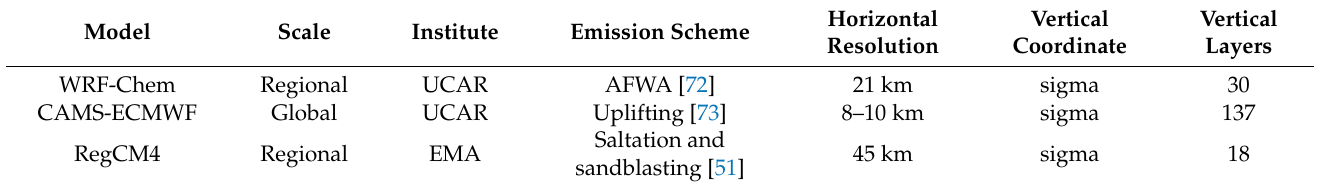
Table 2. Main characteristics of the numerical models used in this